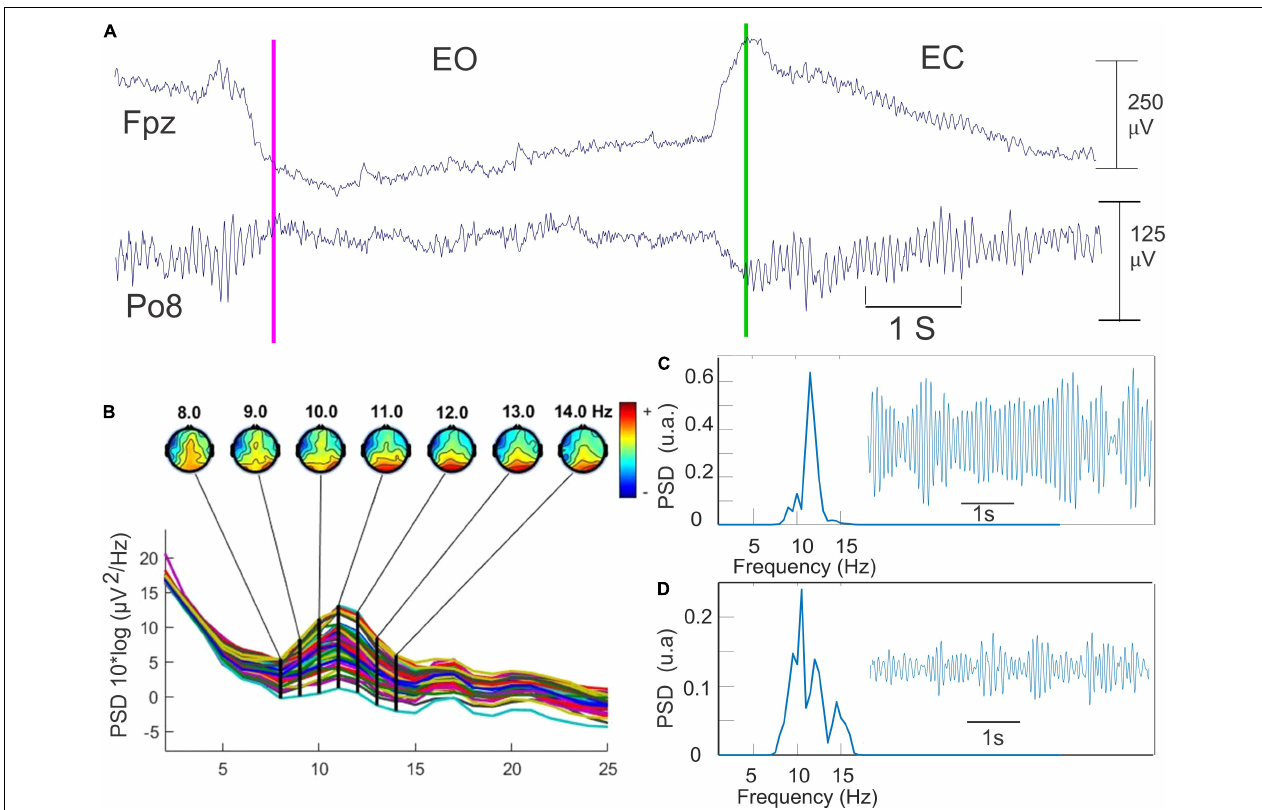
FIGURE 2 | The methodology used for the quantification of the alpha oscillation. (A) Detection of opening (pink line) and closing of the eyes (green line) in Fpz recording. The topographical map provided by the EEGLab toolbox for detecting the scalp electrode presenting the higher alpha power. (B) An example of 6 s of the filtered EEG data (8–14 Hz) recorded during the eye-closed (EC) state. (C) Fast Fourier transform of this data set corresponding of the EC state. (D) the same procedure as in C but during the EO